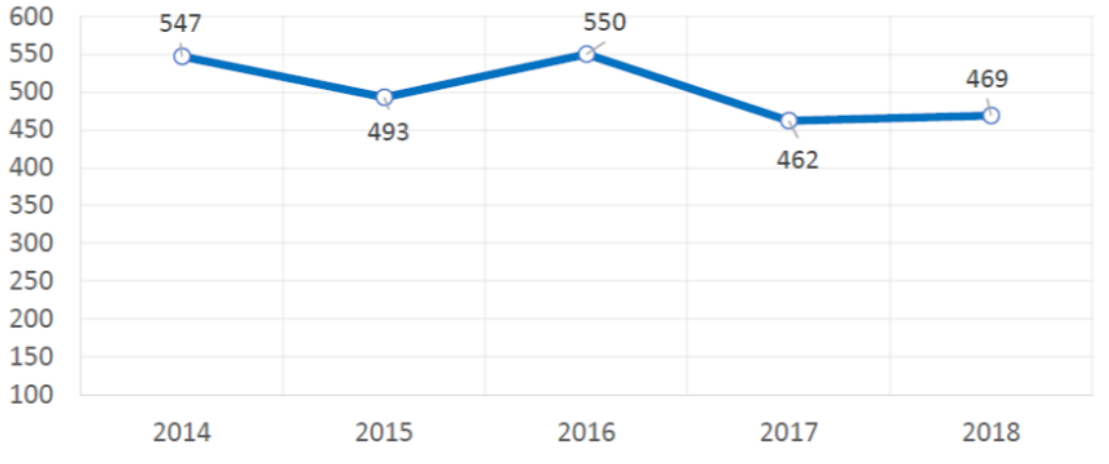
Figure 2: Earnings before taxes of METROSTAV (CZK million), (source: Annual report of METROSTAV 2014- 2018, data processed by the authors)